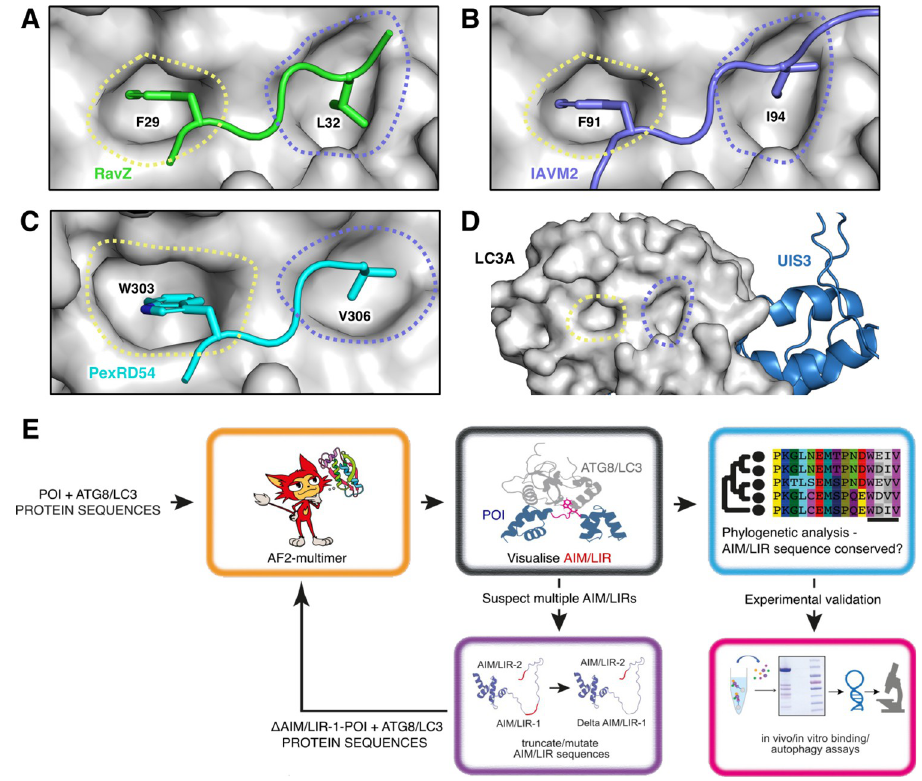
Fig 4. AF2-multimer guided discovery of cross-kingdom interactions. (A–C) RavZ (Legionella—green), M2 (Influenza–slate blue), and PexRD54 ( P . infestans –cyan) interact with their respective ATG8-family member in humans (RavZ, M2) and plants (PexRD54) to produce a pathogenic phenotype. AF2-multimer correctly predicts interactions studied in literature. (D) UIS3 ( Plasmodium –dark blue) does not interact with LC3A via its AIM/LIR pockets. (E) The pipeline for AF2-multimer and phylogeny guided discovery and validation of AIM/LIRs among various species. POI: protein of interest. Data are available in S1 Data. Models coloured based on AF2-multimer prediction confidence are available in S3 Fig. AF2-multimer prediction files are available from https://doi.org/10.6084/ m9.figshare.21533769.v1. AF2-multimer icon by Mirdita and colleagues [55], used under CC BY 4.0 licence